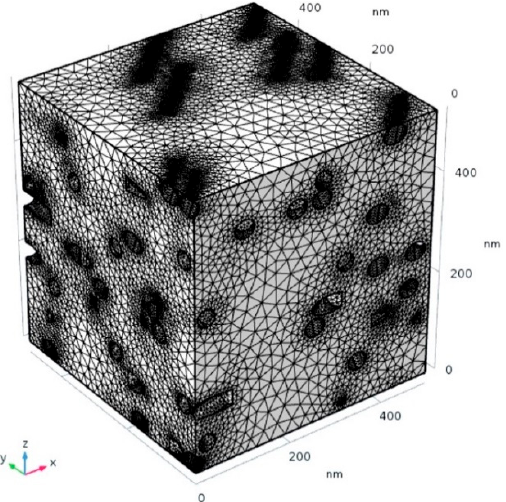
Figure 3. Example of a generated FE mesh of the RVE (volume fraction ≅ 10%).